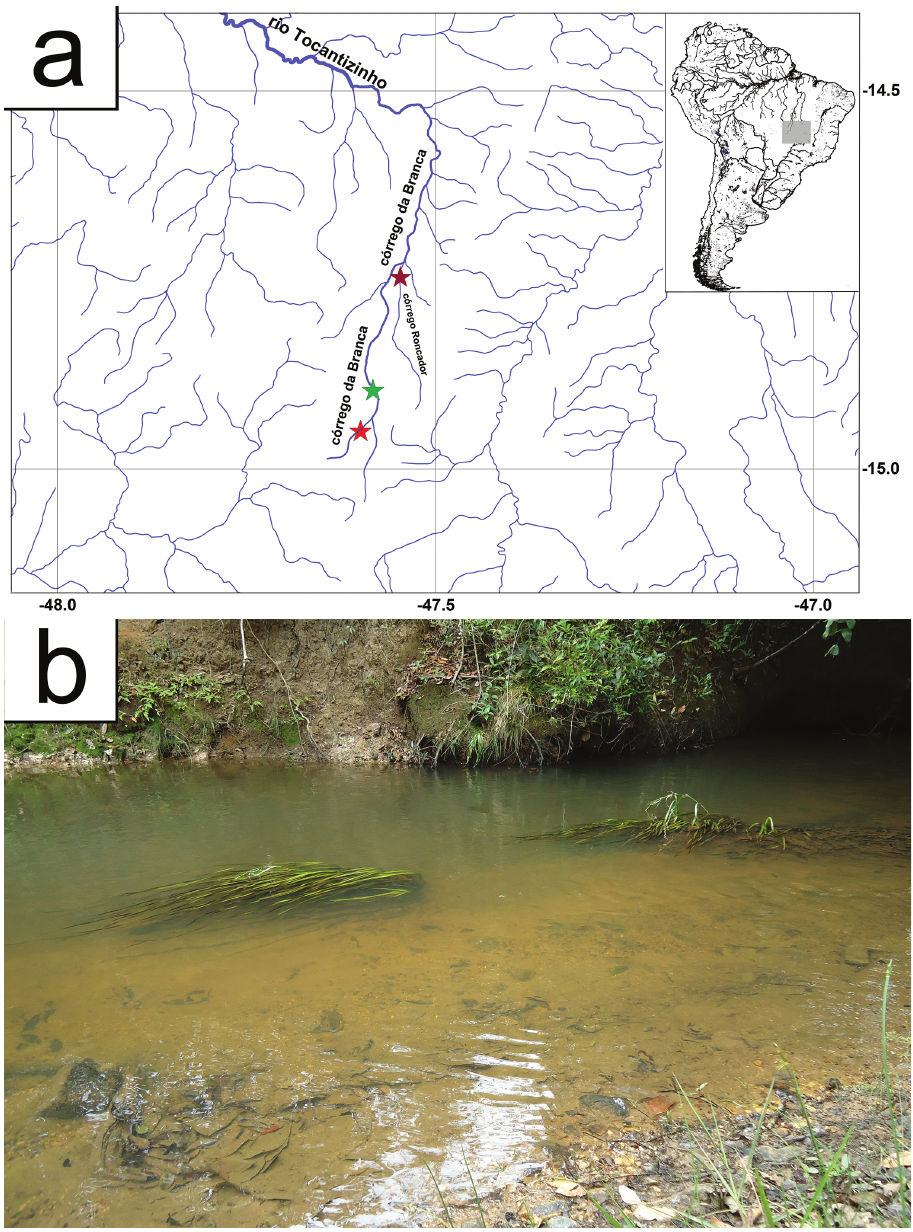
Figure 4. a Map showing the distribution of R. capetinga . Type locality at córrego da Branca, green star – 14°53'47.2"S, 47°34'58.4"W. Paratype localities at córrego da Branca, red star – 14°57'01.6"S, 47°35'57.0"W, and at córrego Roncador, pink star – 14°43'51.3"S, 47°32'34.0"W b Habitat and sub- merged vegetation where the specimens were found in type locality of córrego da Branca, 14°53'47.2"S, 47°34'58.4"W. Photo: LH